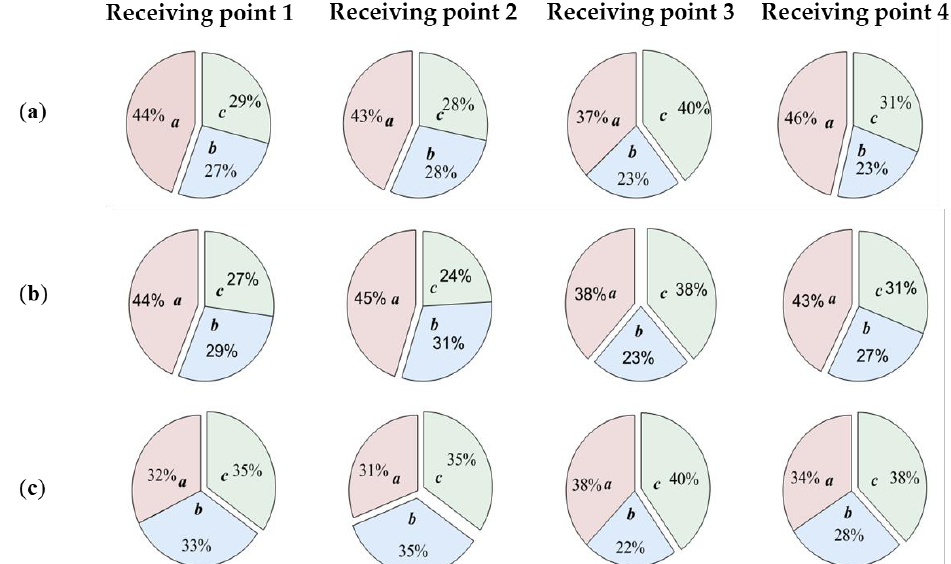
Figure 6. The changes of spatial sound field auditory of the three musical sounds. The colors represent different spatial models: red, blue, and green correspond to a, b, and c models in Table 4. The size of the fan indicates the number of the stimuli selected at a receiving point in this space; the larger the number being selected, the larger the fan area. ( a ) Flute; ( b ) Violin; ( c ) Symphony.